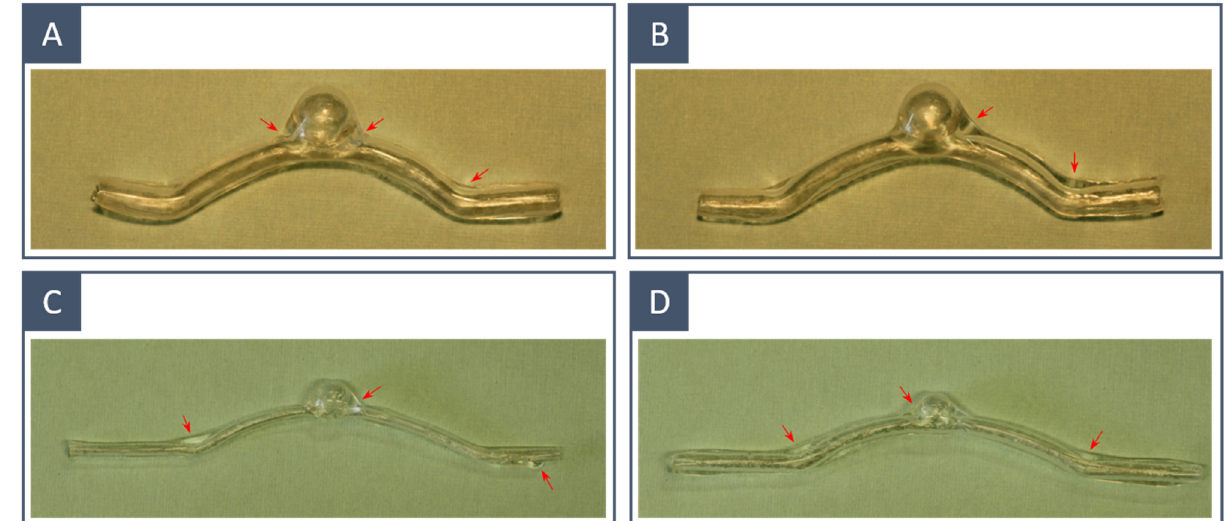
Figure 7. Patient-specific phantoms with the corresponding 3D surface model. The surface models were selected from those available in the free AneuriskWeb dataset repository. Models ( A , B ) were obtained with an FDM-printed inner mould; models ( C , D ) were obtained with an SLA-printed inner mould.